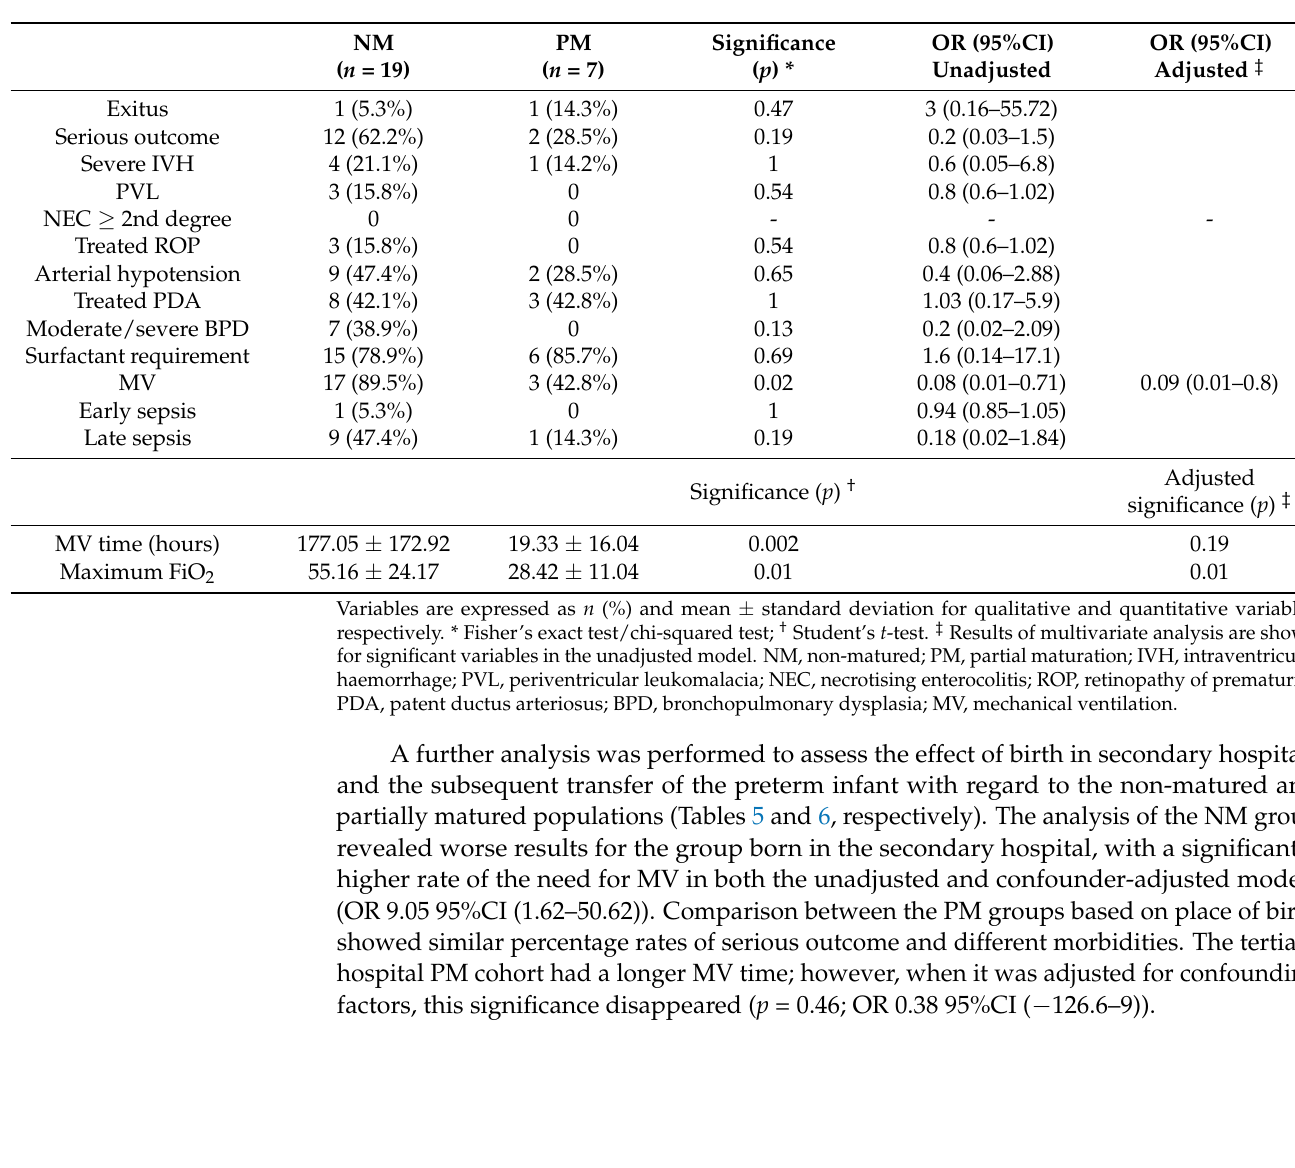
Table 4. Comparison of the secondary hospital birth population based on the maturation